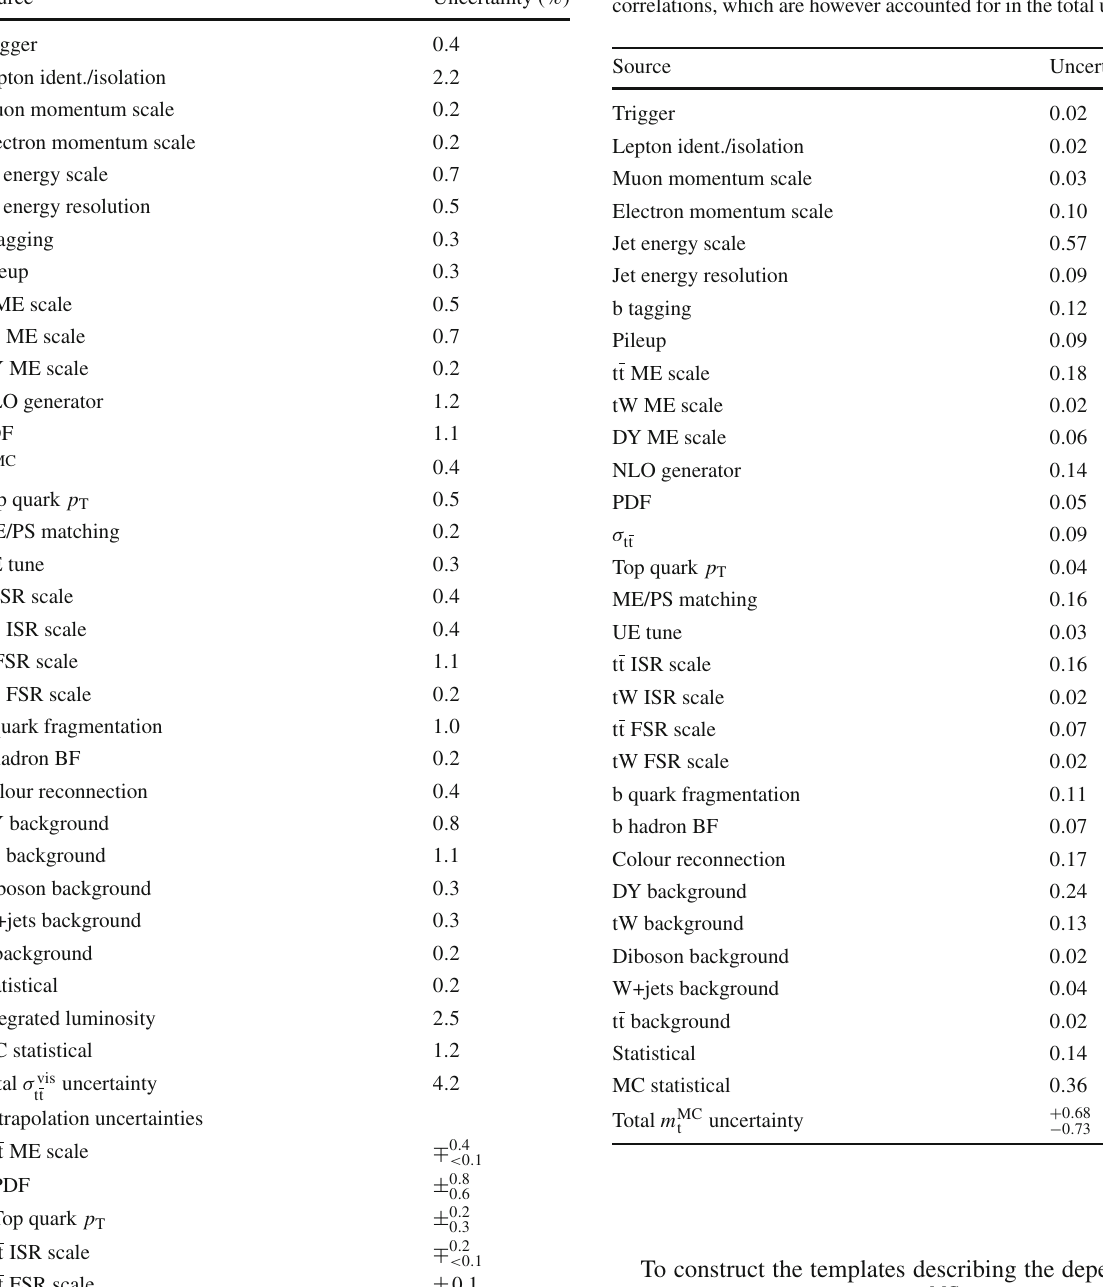
Table 2 The same as Table 1, but for the simultaneous fit of σ tt and m MC